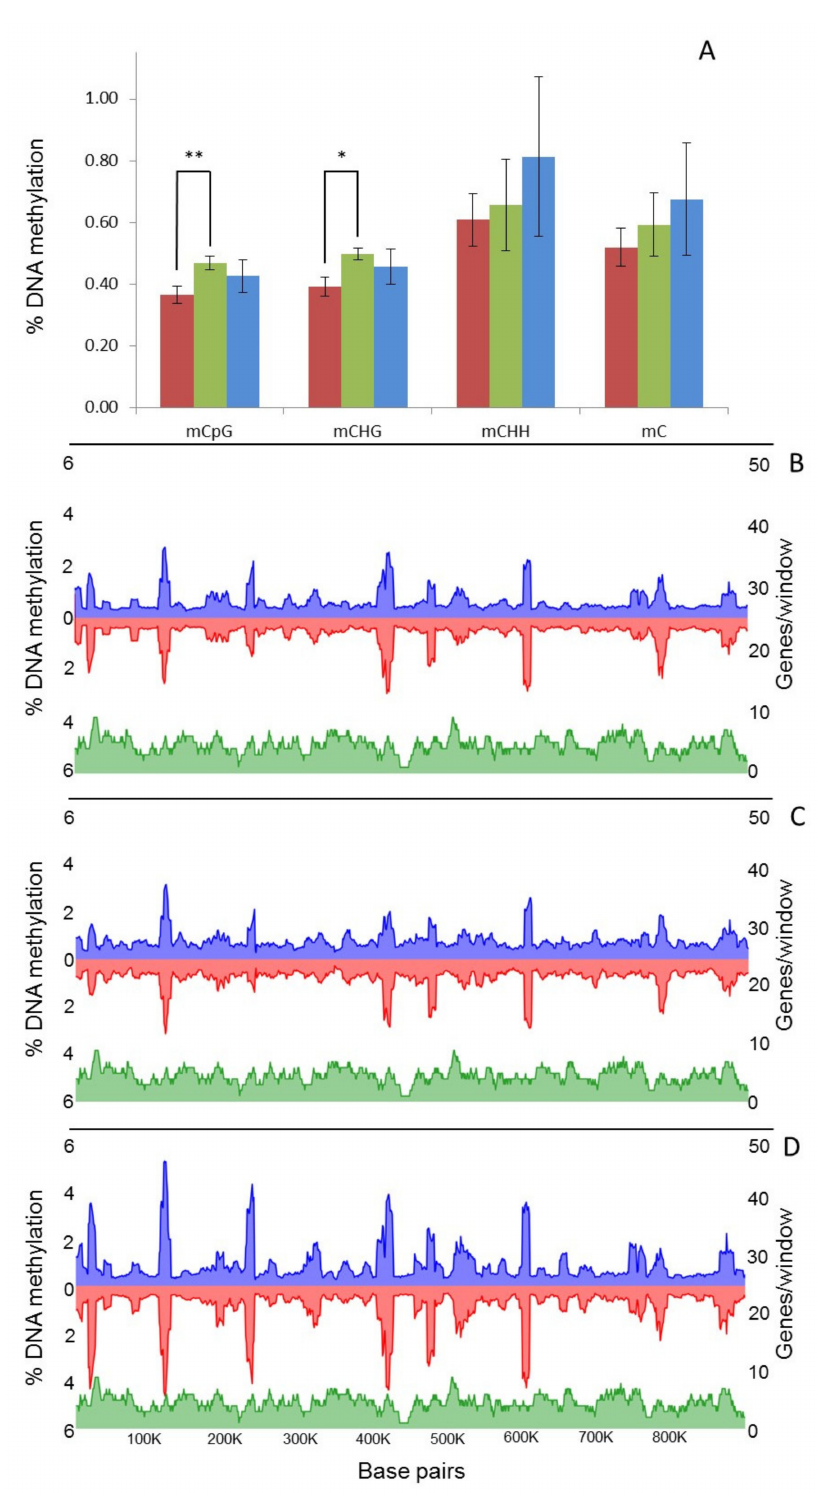
Figure 3. Global changes on genomic distribution and levels of DNA methylation in B. cinerea . ( A ) Global average percentage of mCs ((number of mCs/total Cs) × 100) at each time point (T1, red; T8, green; T8P, blue). ( B – D ) Methylcytosines (mCs) density from each strand (blue, positive and red, negative strand) across Supercontig 1.1 at each time point ( B = T1; C = T8 and D = T8P) was calculated and plotted as the percentage of mCs (as above) in each 10 kb window. * ( t -test; p < 0.05) and ** ( t -test; p <